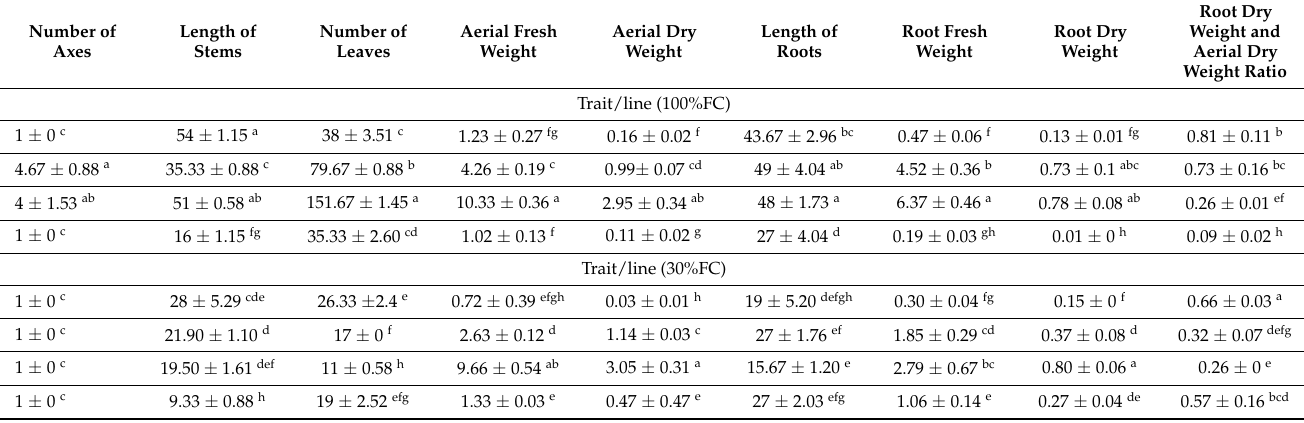
Table 2. Means of measured characters for the four lines of M. truncatula under control treatment and 30% of field capacity. Number of